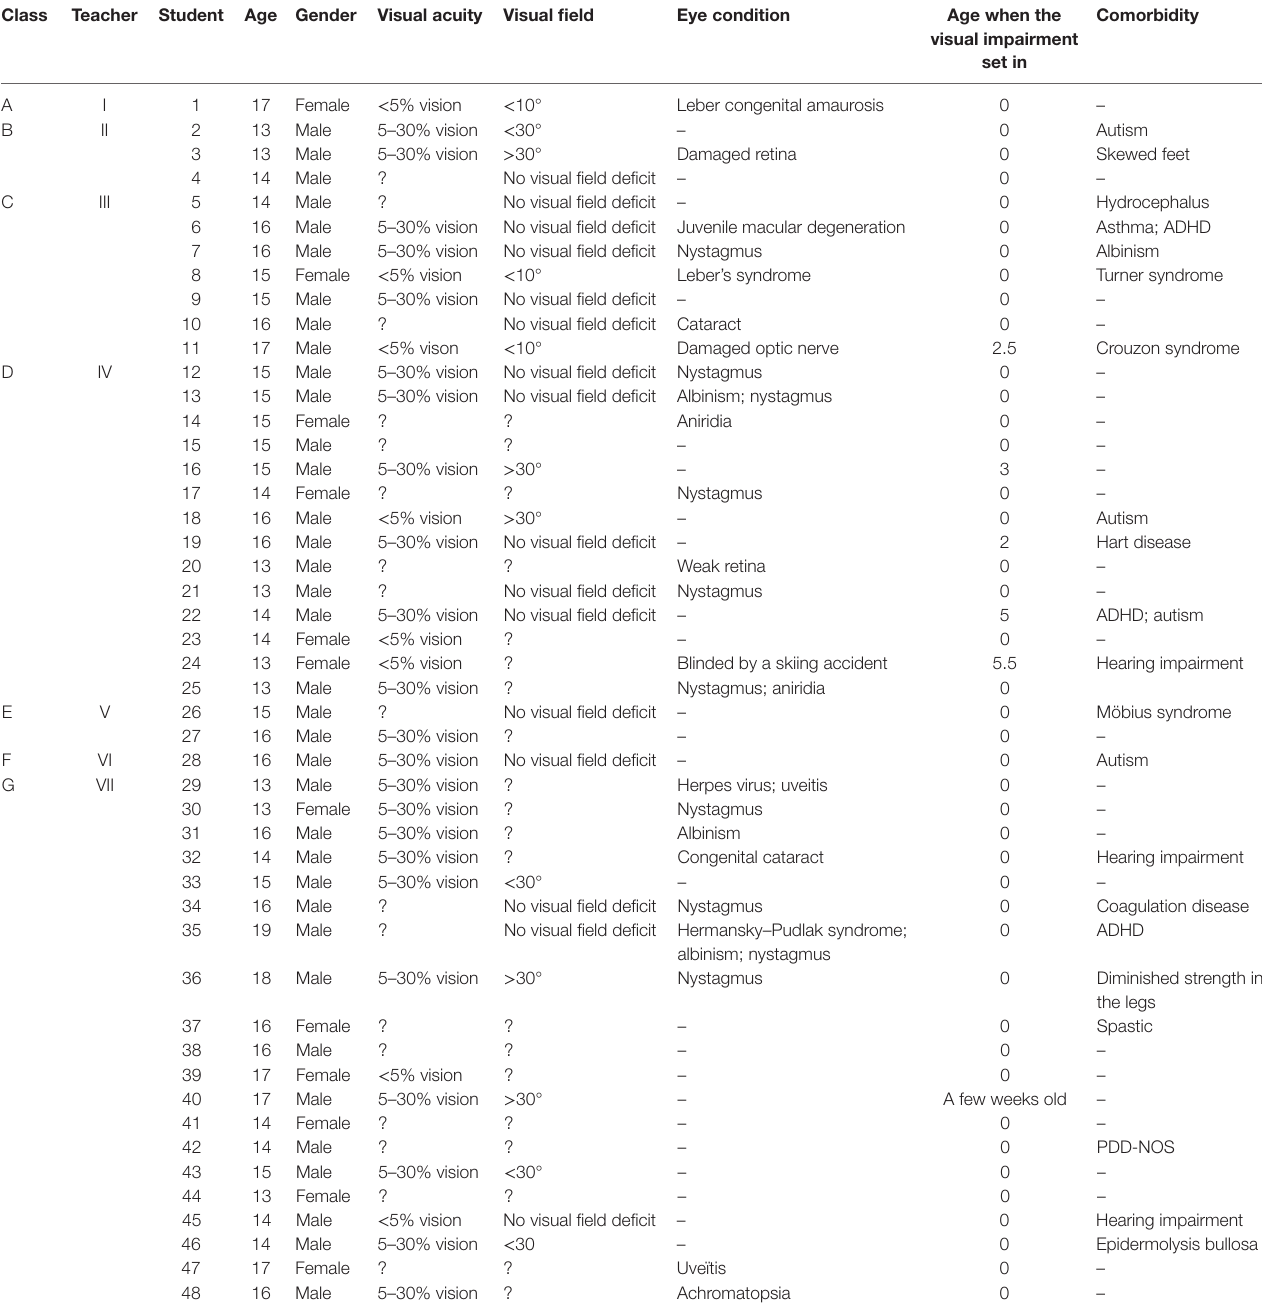
Table 2 | Student